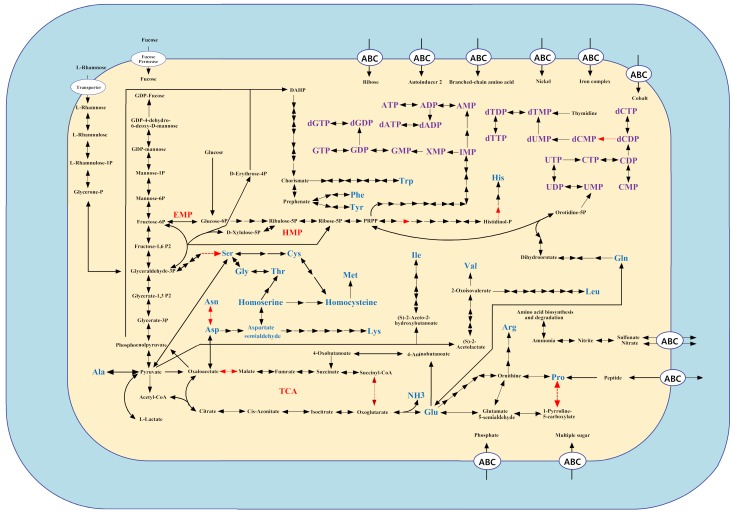
Schematic of metabolic pathways in strain Gsoil 348T.The black arrows represent enzymes existed in the genome, while the red arrows indicated that the enzyme was not encoded by the genome.